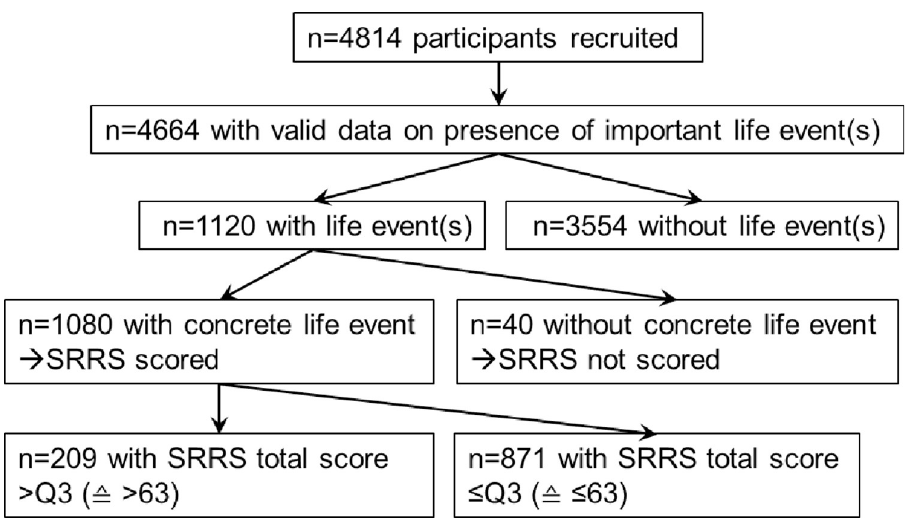
Fig 1. Flowchart of the Heinz-Nixdorf Recall analyses samples. SRRS, Social Readjustment Rating Scale.